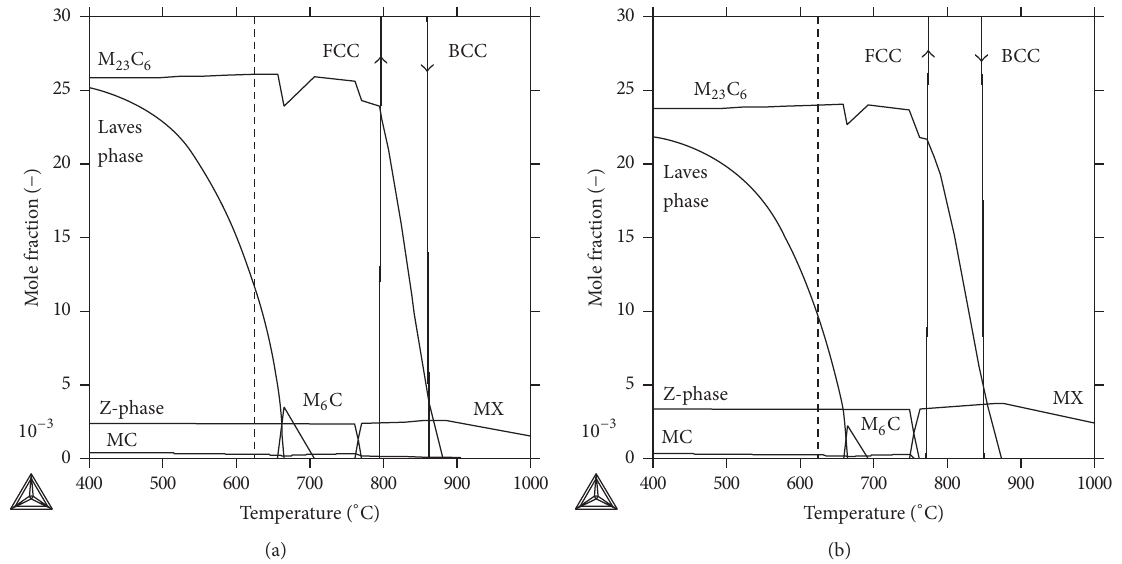
Figure 7: Temperature dependence of mole fractions of equilibrium phases occurring in CB2 steel BM (a) and WM